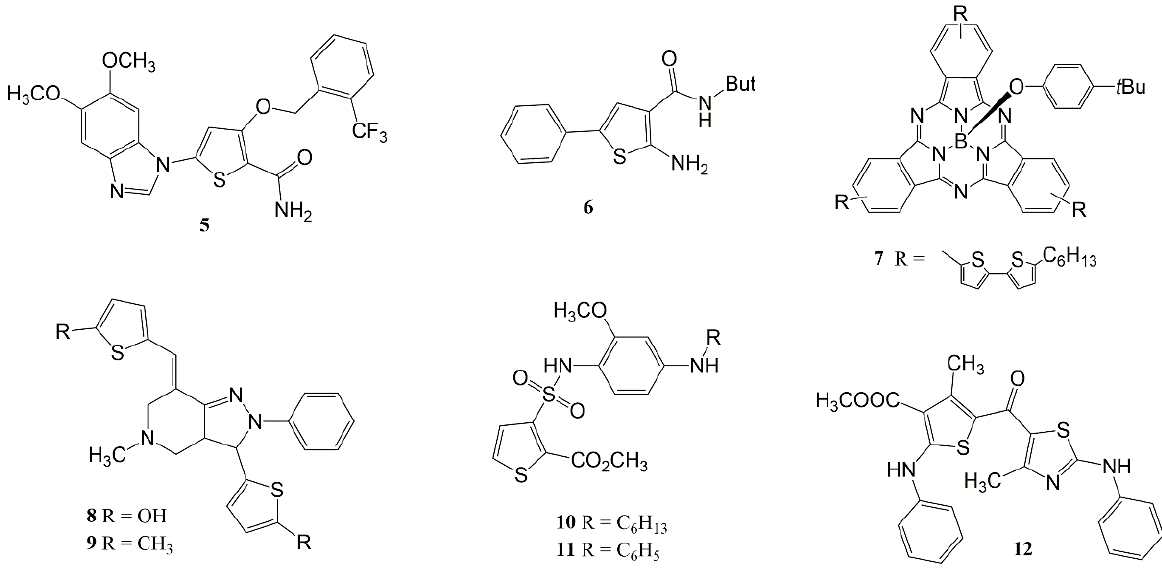
Figure 4. Chemical structures of thiophene-based compounds, which modulate gene expression and/or inflammatory cytokines.